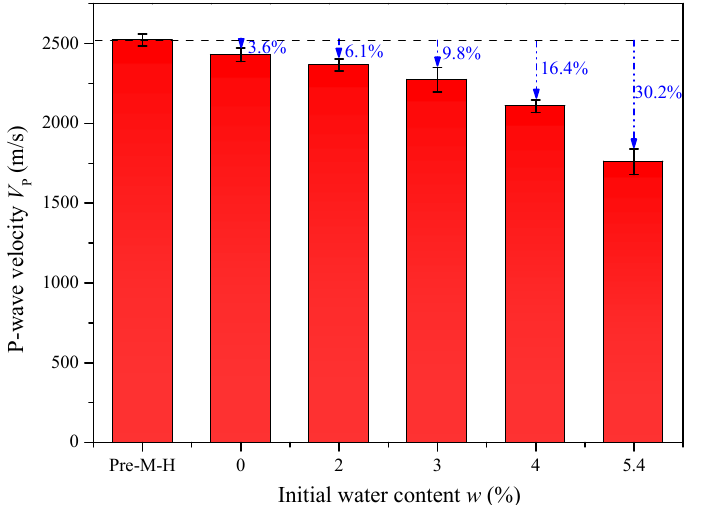
Figure 14. P-wave velocity of sandstone samples vs. initial water content before and after microwave treatment.